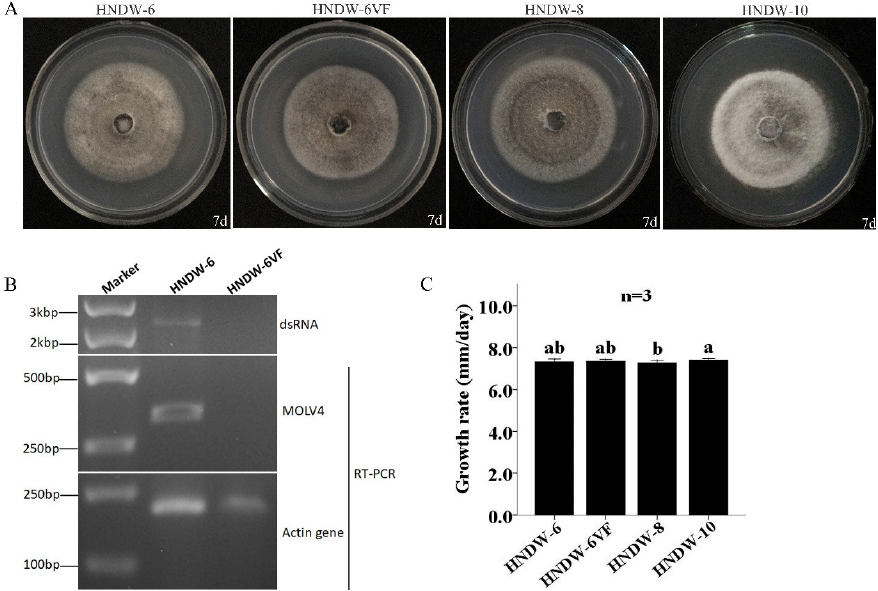
Figure 5. Virus elimination and biological comparison between the virus-containing strain HNDW-6